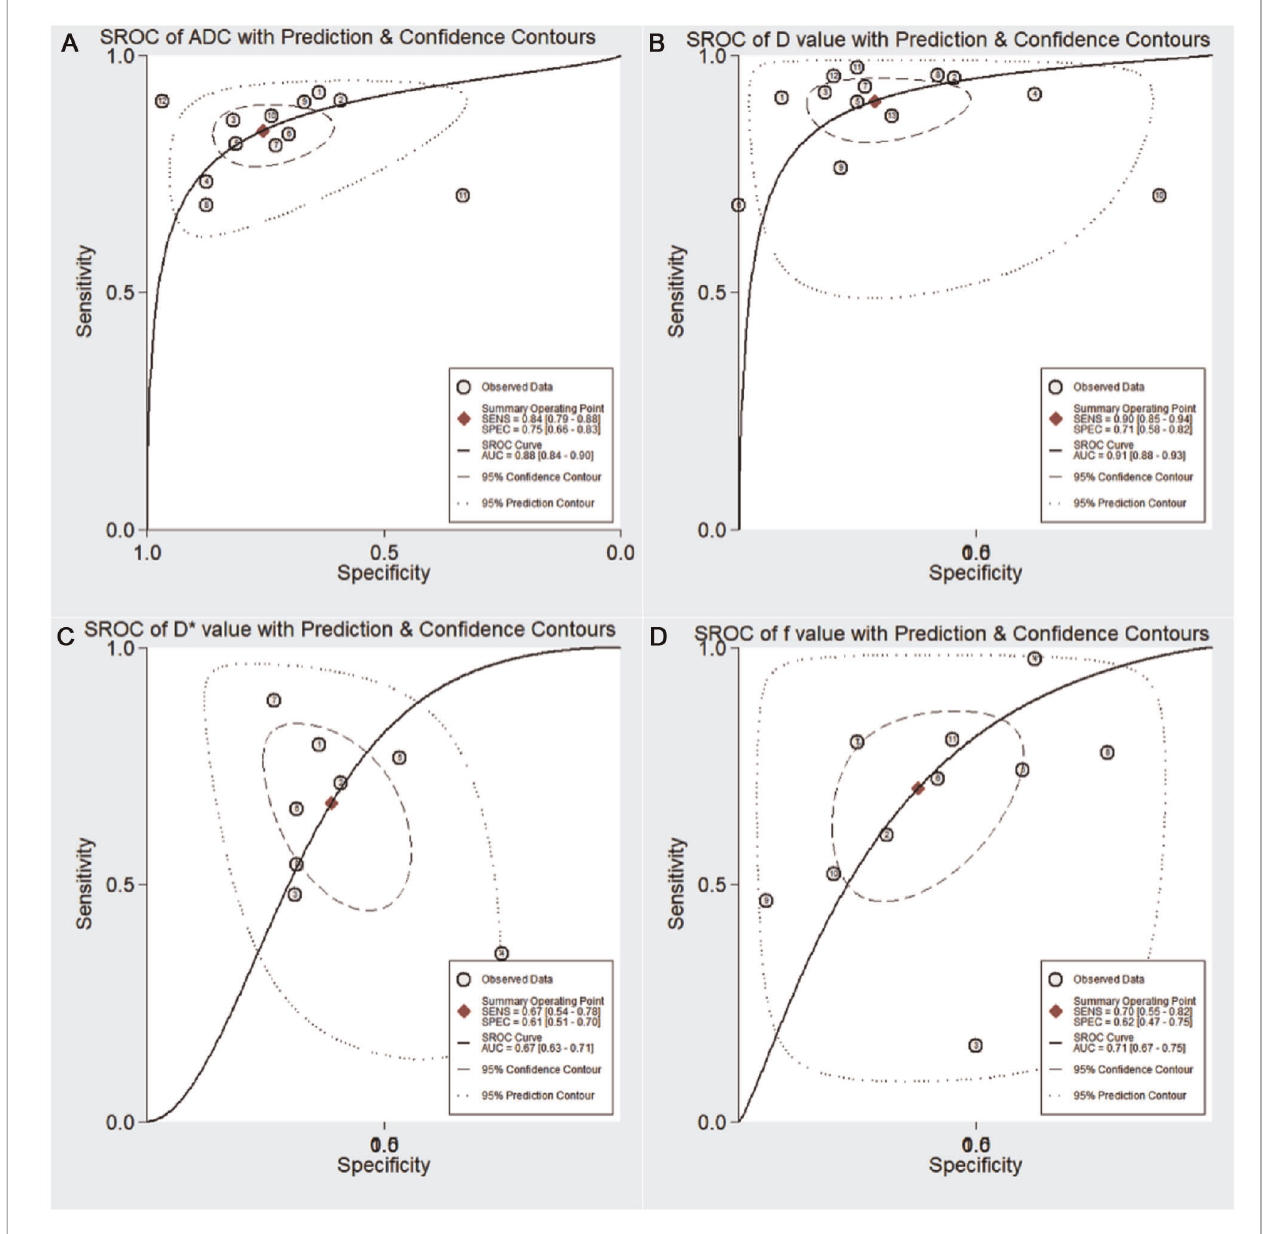
FIGURE 9 | Summary receiver operating characteristic (SROC) curve of the ( A ) apparent diffusion coef fi cient (ADC value); ( B ) tissue diffusivity ( D value); ( C ) pseudo- diffusivity ( D * value); and ( D ) perfusion fraction ( f